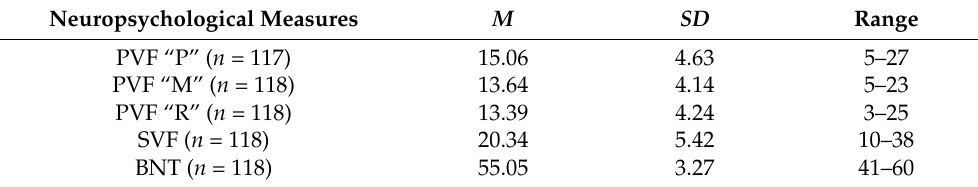
Table 3. Raw scores on neuropsychological